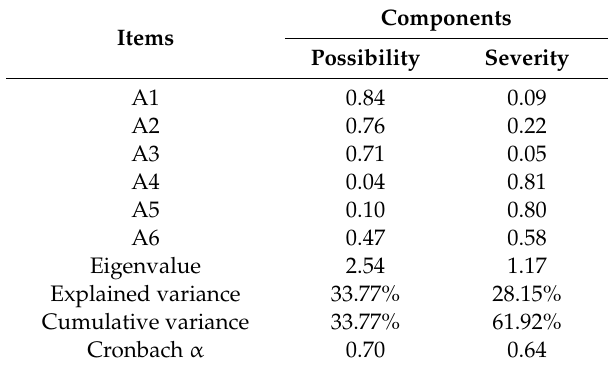
Table 2. Component matrixes for respective components of risk perception after